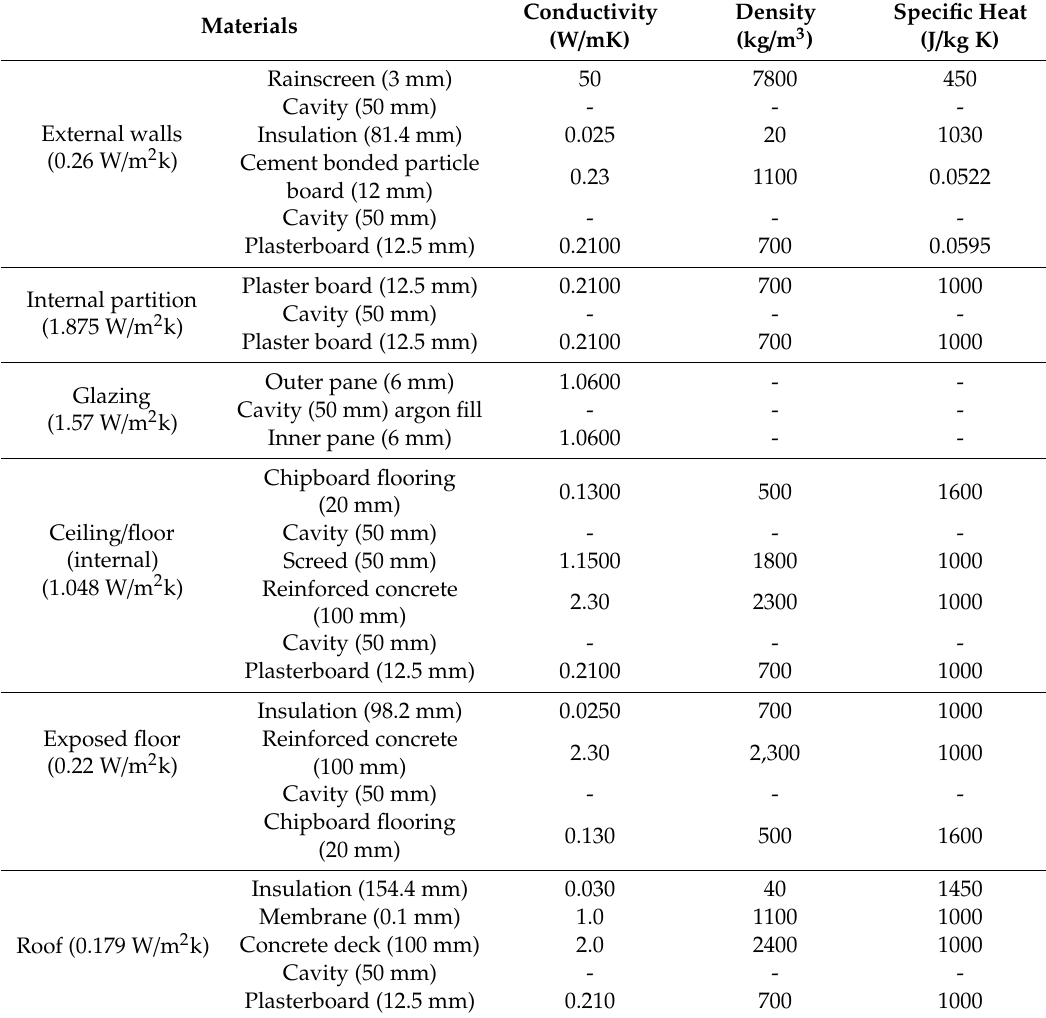
Table 5. Construction materials (IES-VE).